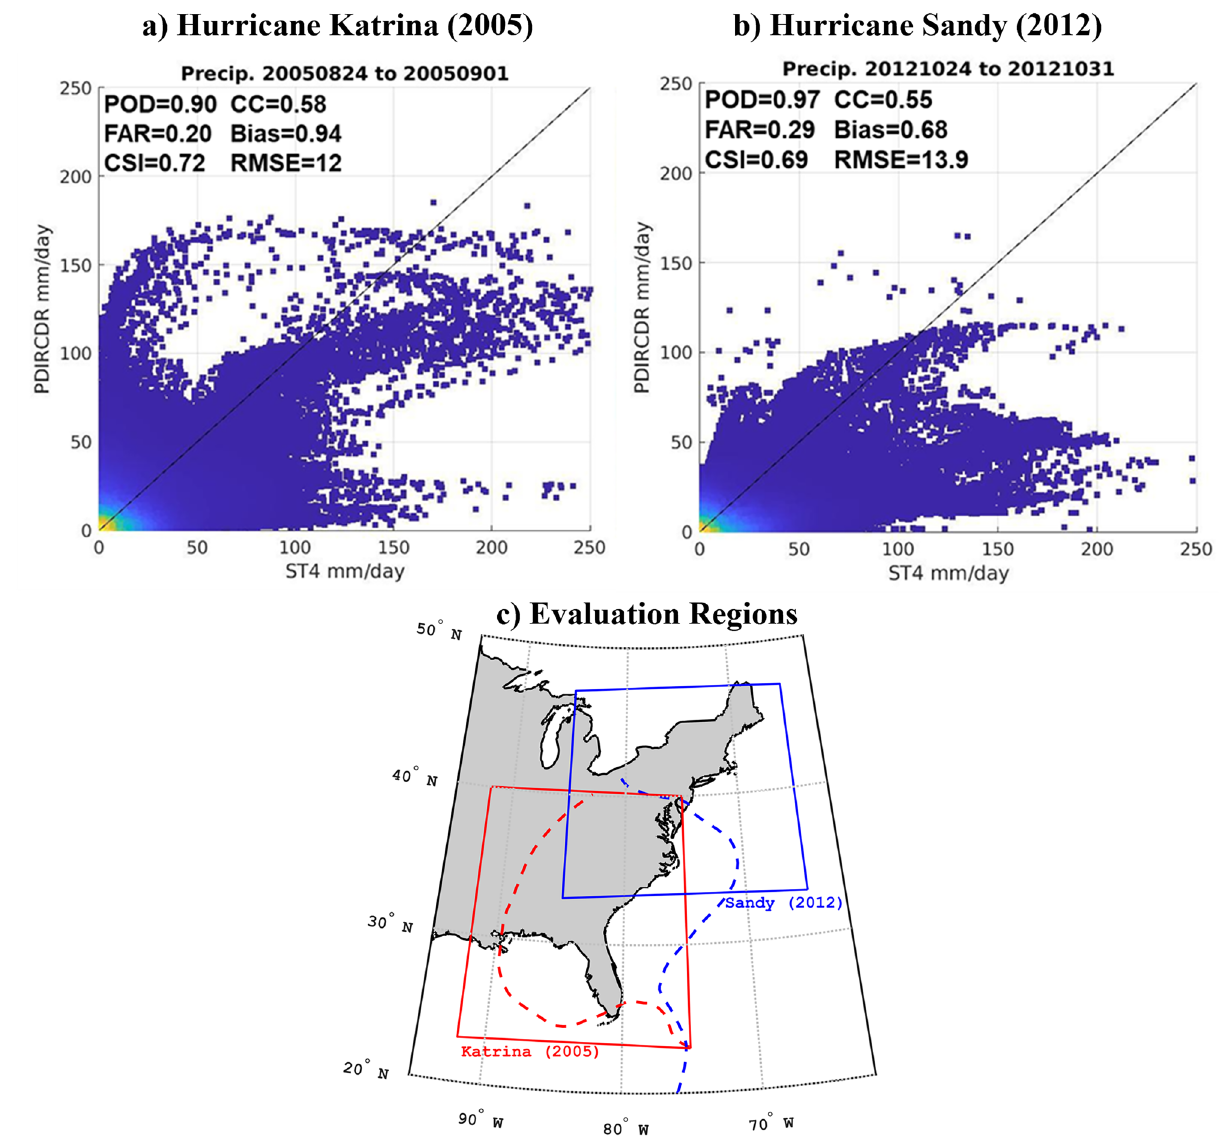
Figure 8. Evaluation of PDIR-CDR rainfall data against Stage IV (ST4) radar-gauge data for ( a ) Hurricane Katrina from Aug-24-2005 to Sep-01-2005 and ( b ) Hurricane Sandy from Oct-24-2012 to Oct-31-2012. Scatter plots of daily pixel totals are shown with Probability of Detection (POD), False Alarm Ratio (FAR), Critical Success Index (CSI), Pearson Correlation Coefficient (CC), Multiplicative Bias, and Root Mean Squared Error (RMSE) scores superimposed. The scatterplot’s color map represents the density of points, with the greatest density at the origin point in yellow. ( c ) The spatial domain (solid line) of each scatter plot with the corresponding hurricane track (dashed line). Hurricane Sandy is shown in blue while Hurricane Katrina is shown in